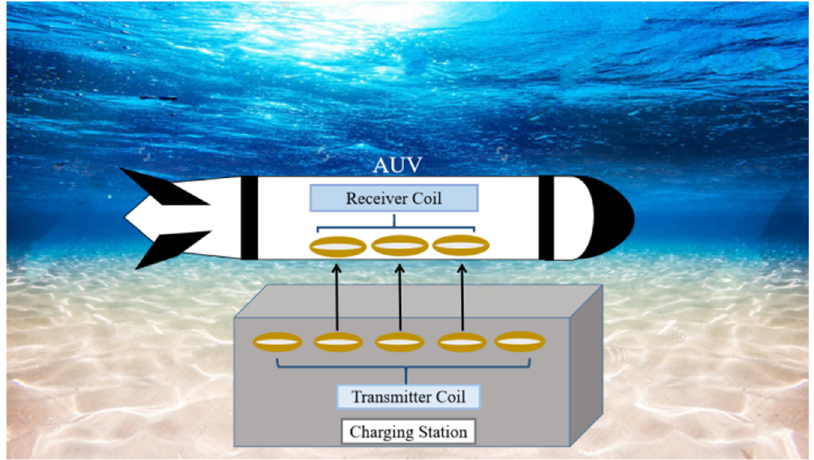
Figure 30. MIMO UWPT for self-charging of AUV. UWPT systems are not only influenced by effective medium constraints such as permeability, permittivity and conductivity but also affected by salinity, ocean currents, pressure, temperature and adherent microorganisms. All these factors severely impact multiple environmental factors as current studies only focus on temperature, salinity and sealing of EM couplers for deep-sea applications where high pressure is a critical